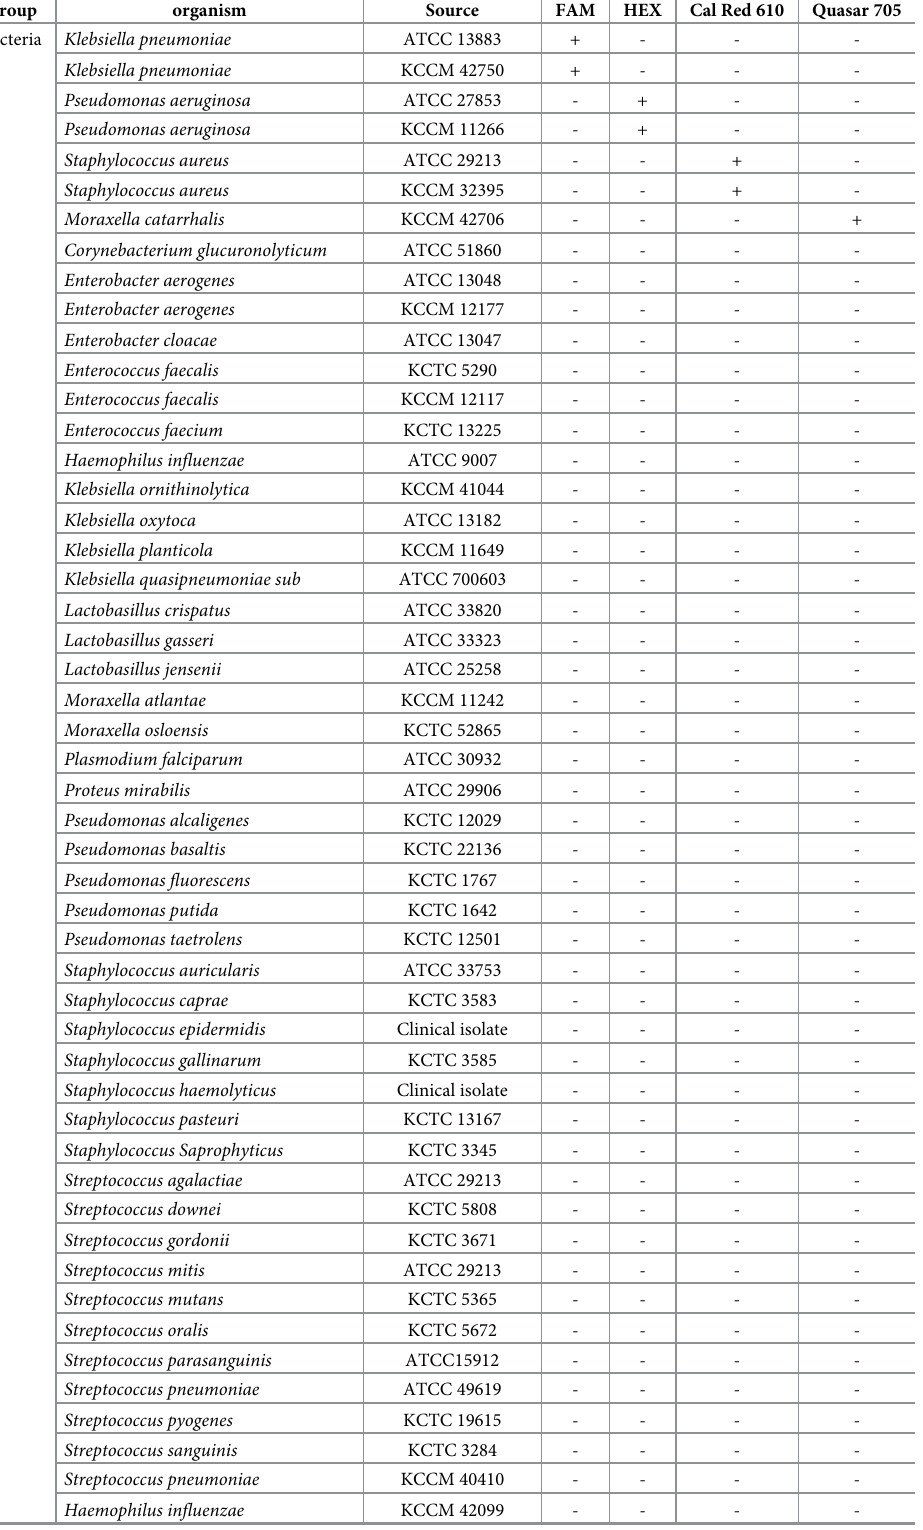
Table 2. Sixty-nine isolates of global origin for analytical specificity of target pathogens.